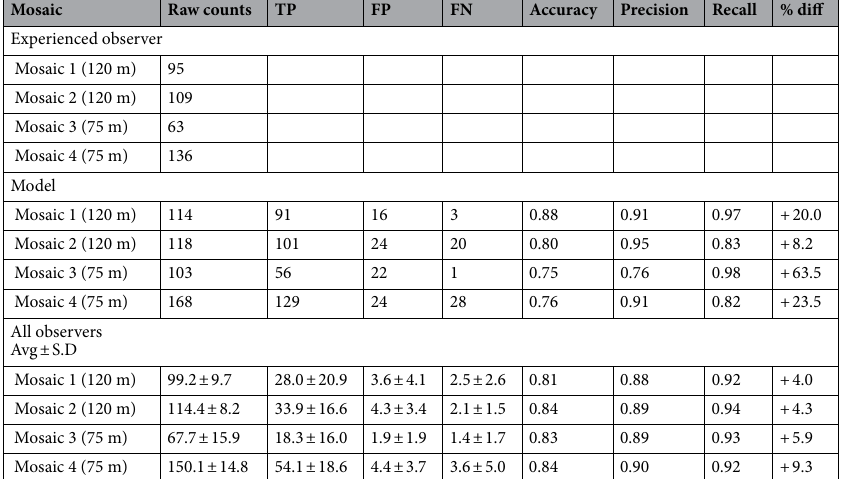
Table 1. Comparison between the Faster-RCNN model, expert observer (AFB), and naïve observers counts (raw counts, and true positives: TP, false positives: FP, false negatives: FN, accuracy, precision, recall, and percentage difference: % diff.) of caribou for each of the mosaics at 120 m and 75 m AGL in Wapusk National Park, Manitoba,